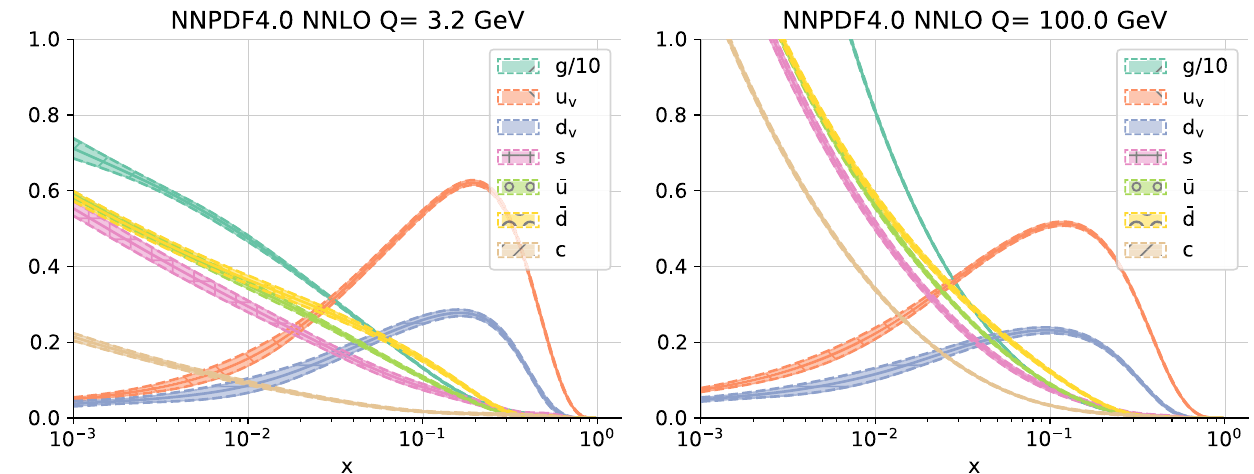
Fig. 1 The NNPDF4.0 NNLO PDFs at Q = 3 . 2 GeV (left) and Q = 10 2 GeV